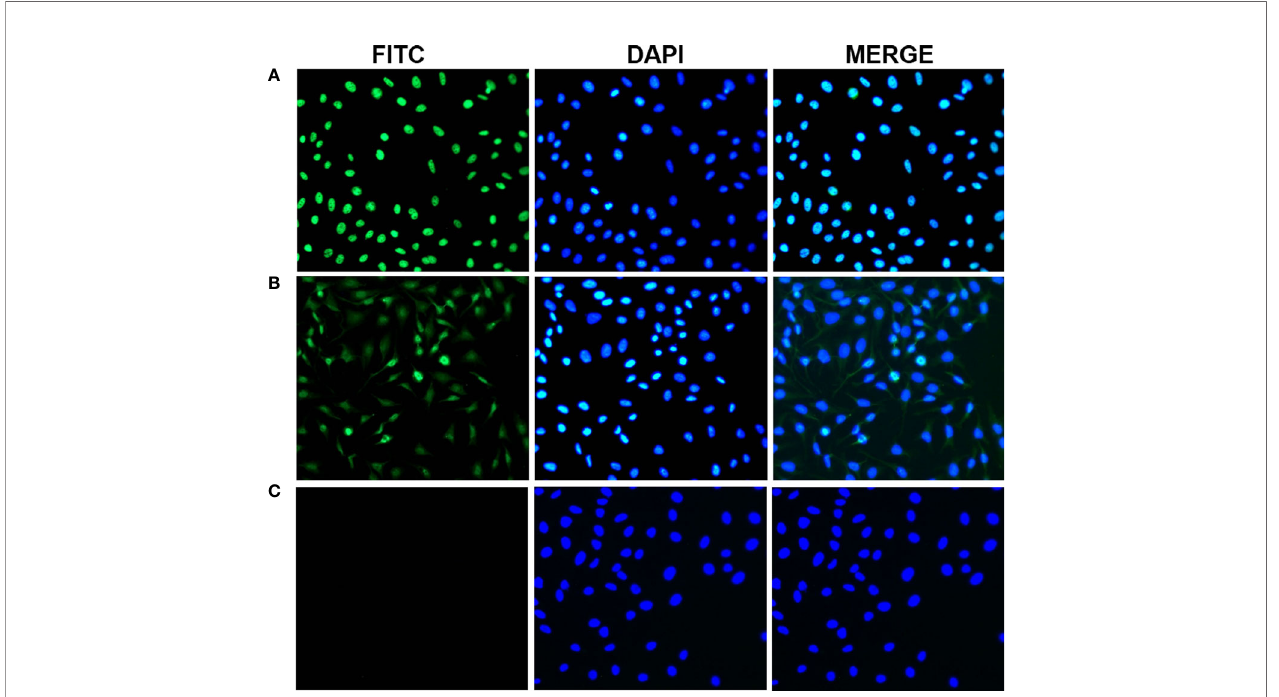
FIGURE 7 | Representative immuno fl uorescence staining pattern of anti-14-3-3 zeta autoantibody with positive liver cirrhosis (LC) serum. (A) A polyclonal anti-14-3- 3 zeta antibody that showed a cytoplasmic immuno fl uorescence staining pattern was used as a positive control. (B) A representative anti-14-3-3 zeta autoantibody- positive LC serum sample demonstrated an intense staining pattern. (C) normal human serum (NHS) was used as a negative